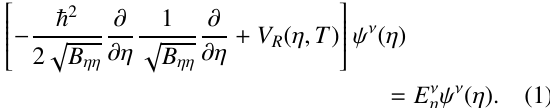
Figure 1. Fragmentation potential with respect to the frag- ment mass for 48 Ti + 40 Ca → 88 Mo ∗ reaction at extreme (cid:96) -values ( (cid:96) = 0&64) for the spherical and β 2 -deformed fragments in exit